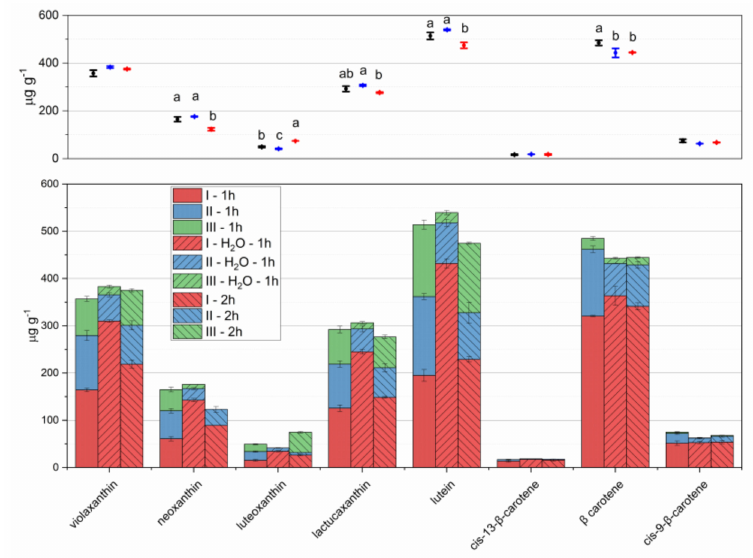
Figure 3. Carotenoids extracted from lettuce microgreens with three repeated extraction steps (I–III in stacked bars), with 1-hour extractions (left bars); initial sample rehydration and 1-hour extractions (central bars); 2-hour extractions (right bars). For steps I and II, 5 mL of pure acetone were used; for step III 5 mL of acetone 70% were used. Means and standard deviations of each step are reported in the stacked bar plot of lower panel; means and standard deviations of overall extraction are reported in the scatter plot of upper panel. Di ff erent letters mean a significant di ff erence at p <